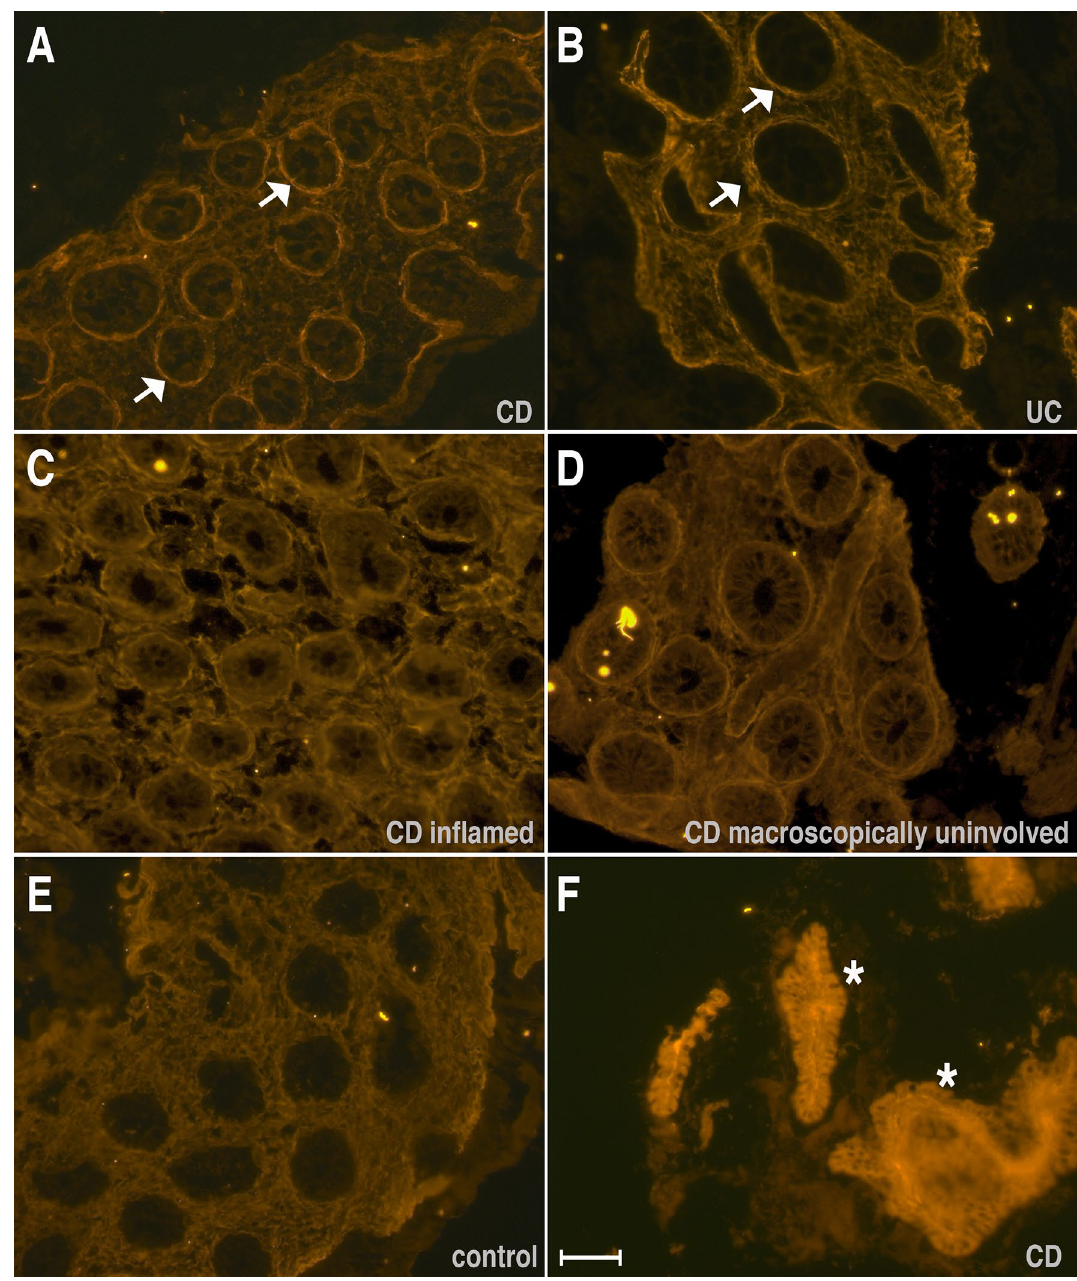
Figure 2. Immuno-fluorescence staining for periostin in colonic tissue. The figure shows representative immuno-fluorescence for periostin on the colonic tissue obtained from controls and IBD patients in the active state. Note the distinctly localised peri-cryptal rings that can be seen in CD ( A , C , D ) and UC ( B ) patients but not in the healthy control tissue ( E ). Interestingly, the peri-cryptal rings can be seen also in the macroscopically unaffected but histologically inflamed colonic mucosa in CD patients ( D ). These high intense areas appear more pronounced in CD patients compared to UC patients. Also note the very intense and diffuse staining of the epithelium and stromal tissue in the surgically resected bowel segment of a CD patient ( F ). Scale bar is 50